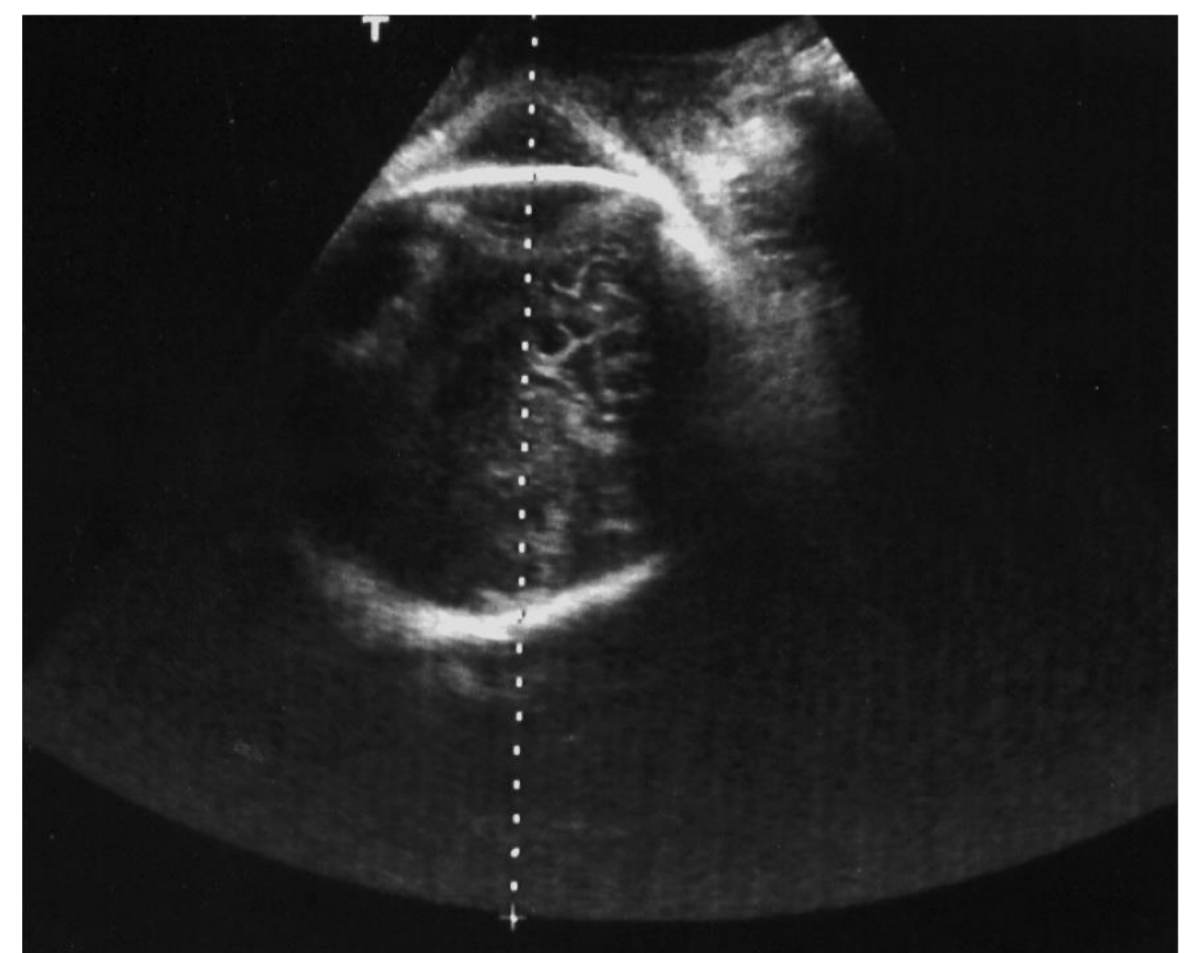
Figure 4. Suprapubic transabdominal sonograph for fetal head assessment; the transverse scan reveals that the occiput position is left anterior, and the cerebellum appears on the upper right quadrant of the screen, the so-called “north cerebellum sign”, typical of anterior asynclitism fetal head attitude.